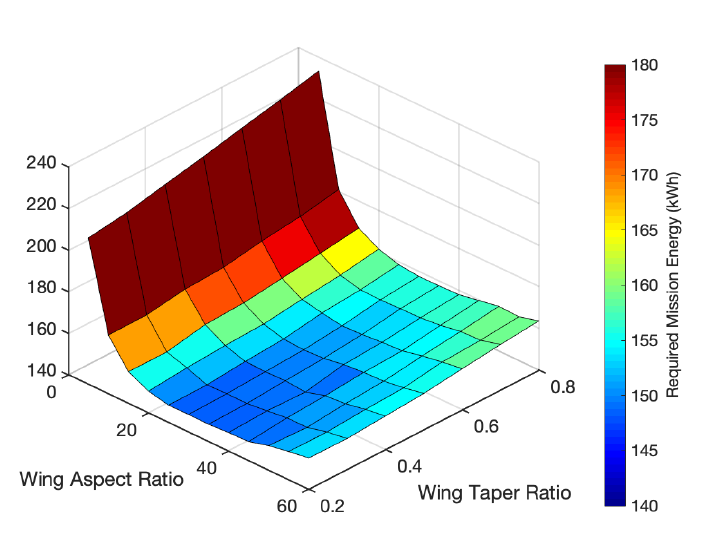
Figure 3. Example of variation in total energy required at current technology levels to complete a mission with a 100 s hover and 50 mile cruise as a function of the assumed wing aspect ratio and taper